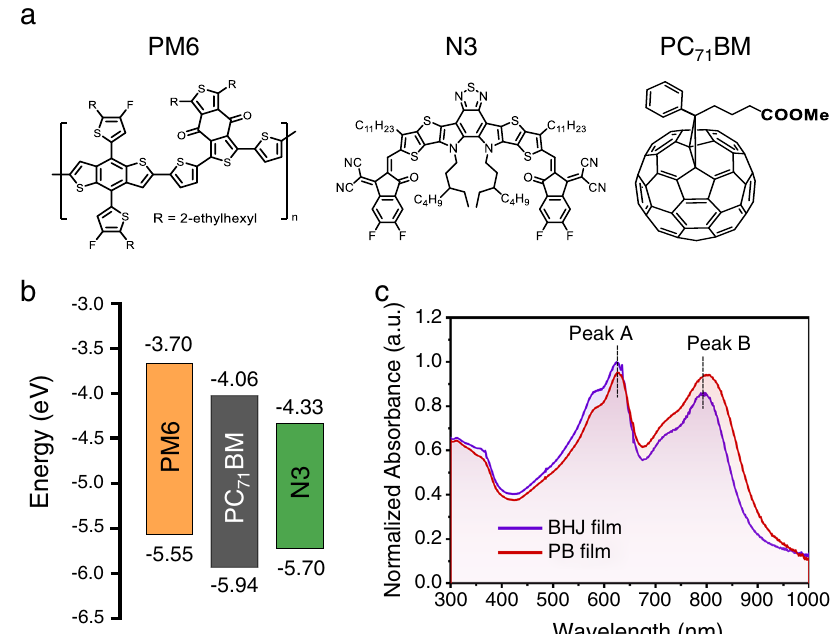
Fig. 1 Molecular structures of donor/acceptors and absorbance of fi lms. a Chemical structures and b energy levels of PM6, N3, and PC 71 BM. c UV – Vis absorption spectra of PM6:N3:PC 71 BM blend fi lm with BHJ or PB